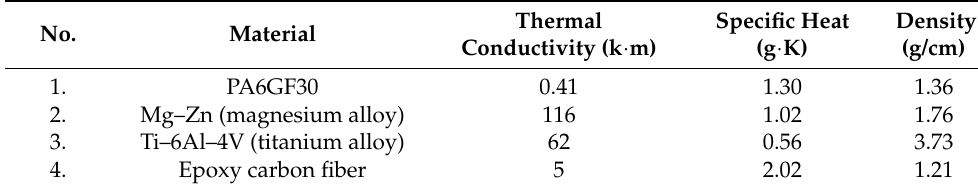
Table 4. Lightweight materials